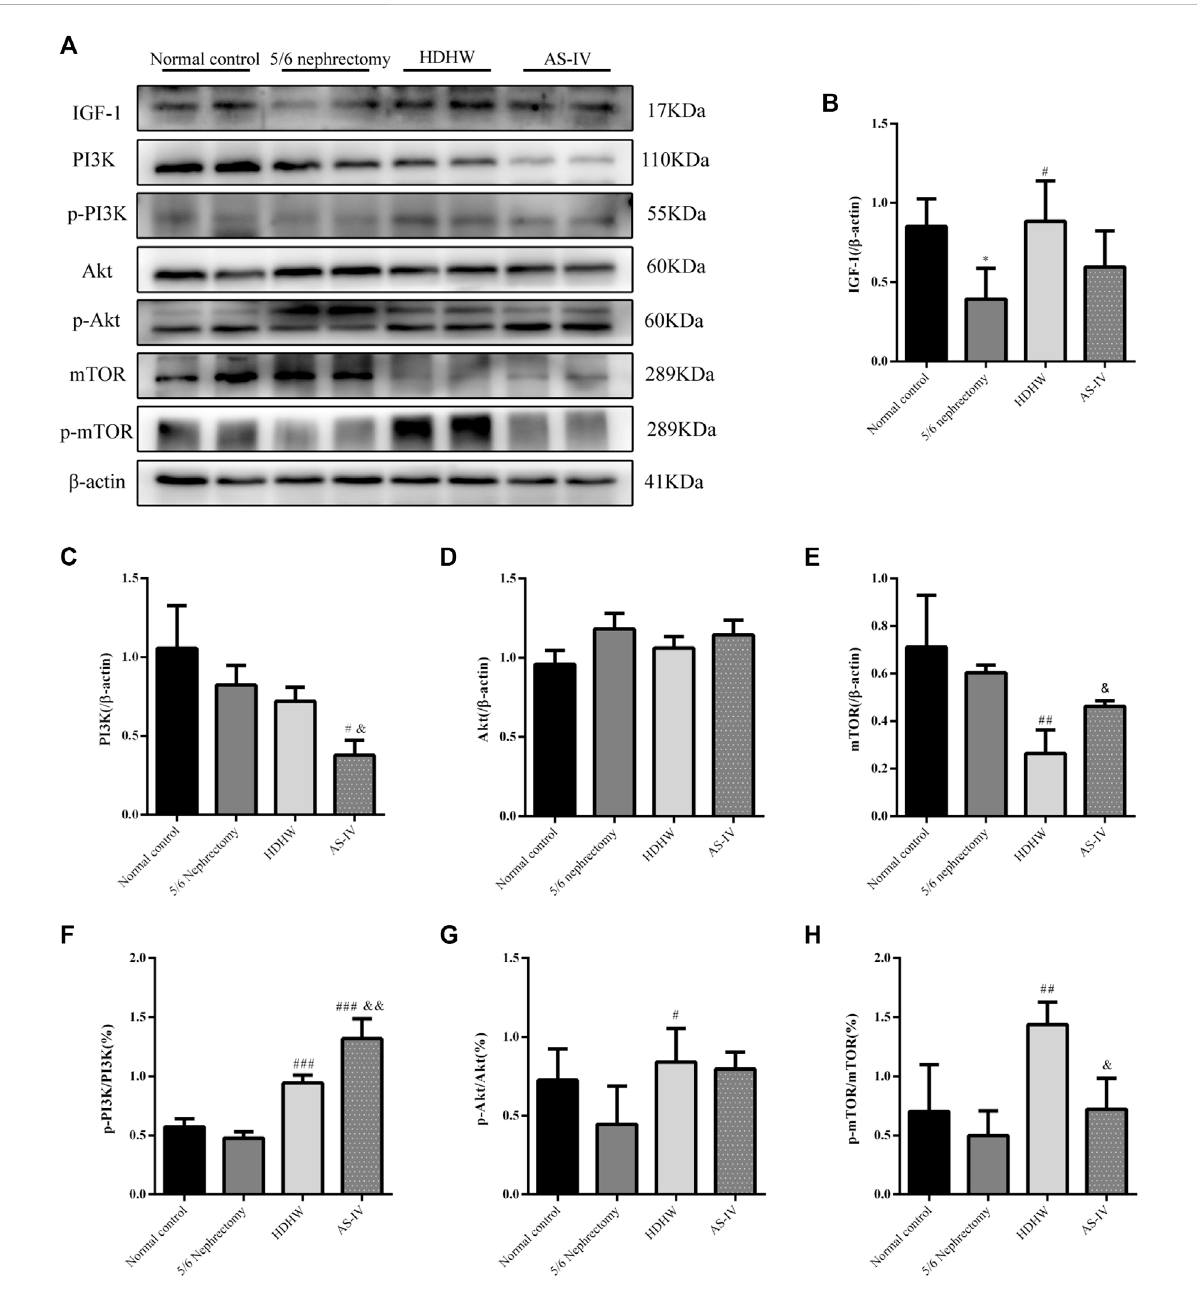
FIGURE 5 EffectsofHeidihuangWan(HDHW)onIGF-1-mediatedPI3K/Akt/mTORpathway. (A) WesternBlottingtodetecttheproteinlevelsofIGF-1,PI3K, p-PI3K, Akt, p-Akt, mTOR, and p-mTOR. (B,C,D,E,F,G,H) Protein concentration analysis. Data are presented as mean ± SD, n = 3. The data are expressed as * p < 0.05: compared with normal control group; # p < 0.05, ## p < 0.01, ## p < 0.001: compared with 5/6 nephrectomy group; & p < 0.05, && p < 0.01: compared with HDHW group,